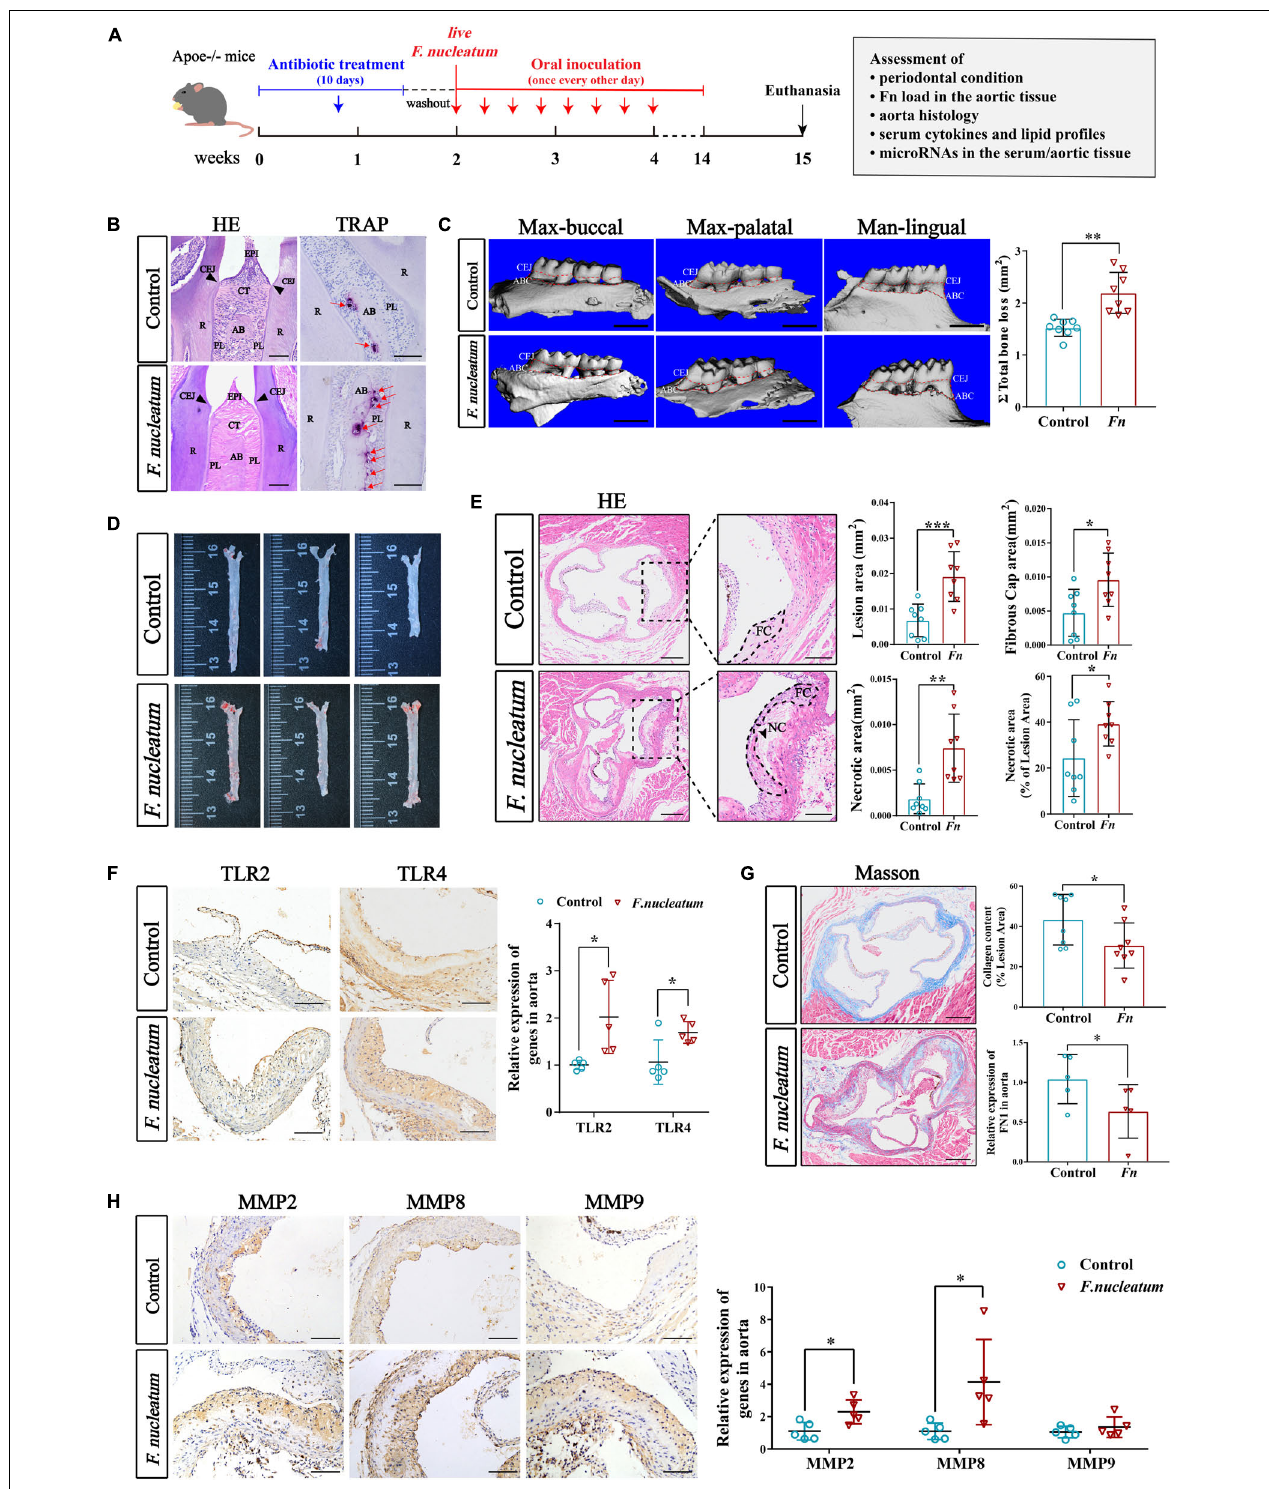
FIGURE 1 | Evaluation of periodontal condition and atherogenesis induced by oral F. nucleatum infection. (A) The animal experimental setup. (B) H&E staining and TRAP staining indicated the interproximal areas between the first and second mandible molars. The red arrows revealed TRAP-positive multinucleated osteoclasts. CEJ, cementum-enamel junction; CT, connective tissue; R, root; EPI, oral epithelium; PL, periodontal ligament; AB, alveolar bone. Scale bars, 100 µ m. (C) The images show the reconstructed three-dimensional images from the computerized tomography of the right maxilla buccal, maxilla palatal, and mandible lingual